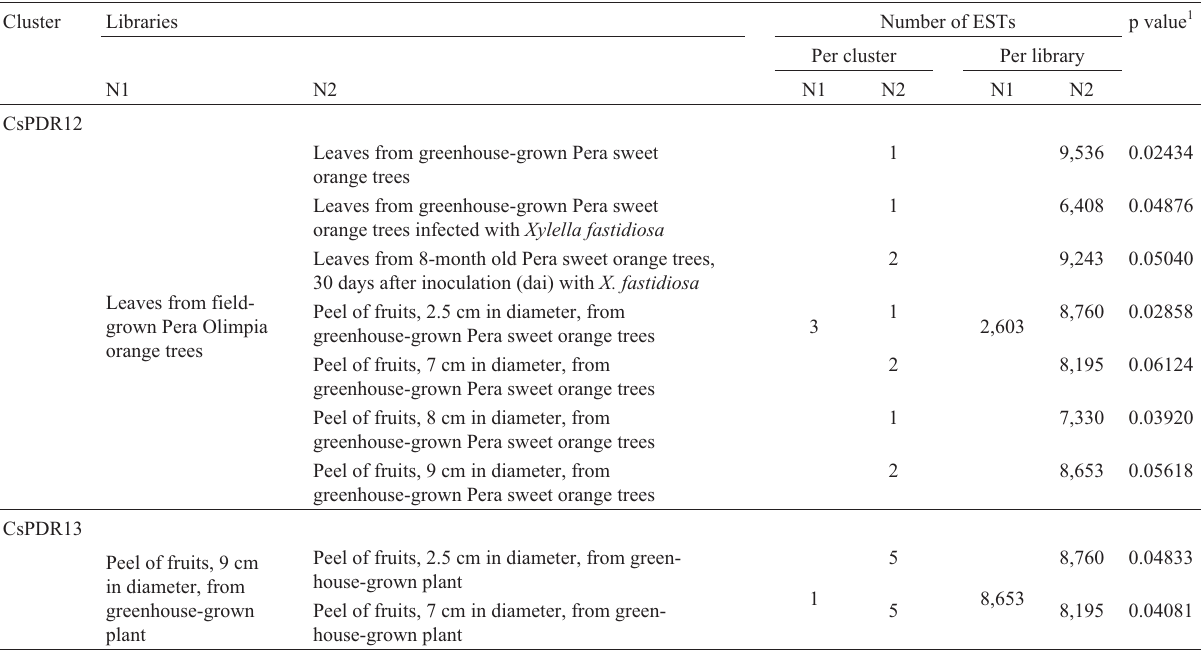
Table 2 - Differentially expressed PDR-like genes in citrus EST libraries detected by electronic subtraction.